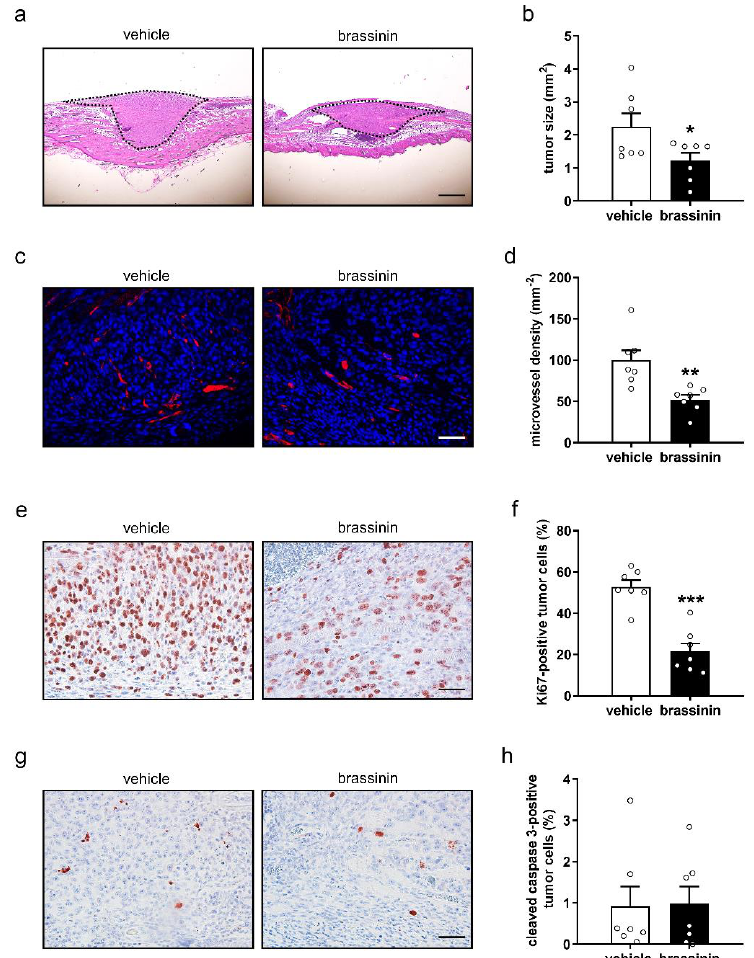
Figure 4. Brassinin reduces TNBC size, vascularization, and tumor cell proliferation. ( a ) Hematoxylin